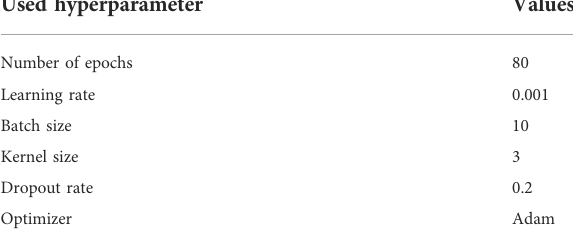
TABLE 4 Optimal hyperparameters used in our proposed method.